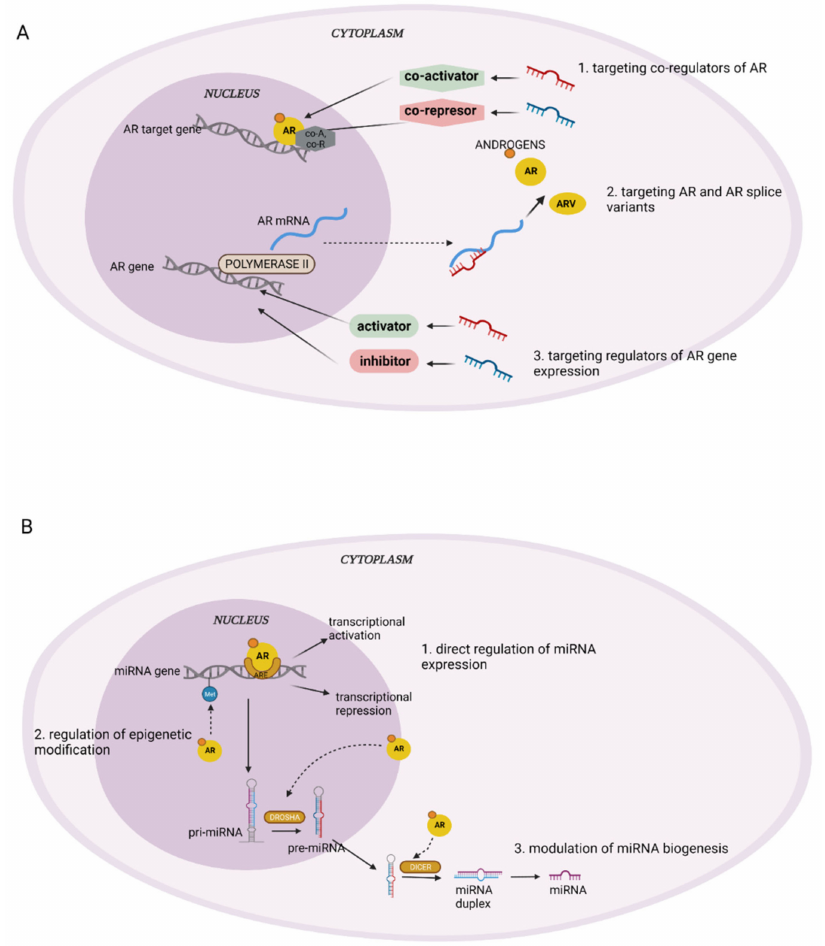
Figure 2. Main mechanisms of AR regulation by miRNA ( A ) and miRNA regulation by AR ( B ). Illustration created using BioRender.com (access date: 28 December